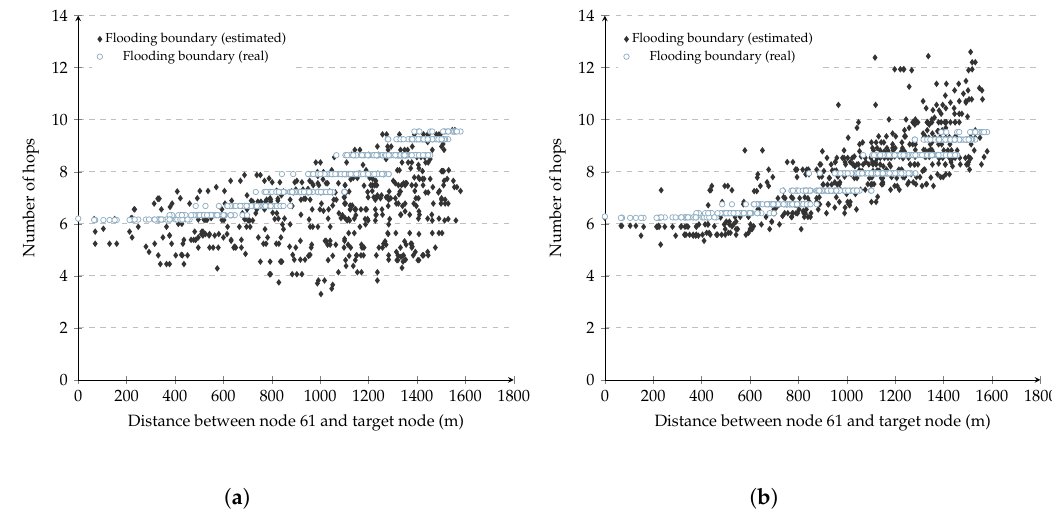
Figure 8. Repeal-flooding boundary (optimized vs. estimated). ( a ) After 2 resource searches; ( b ) after 5 resource searches.